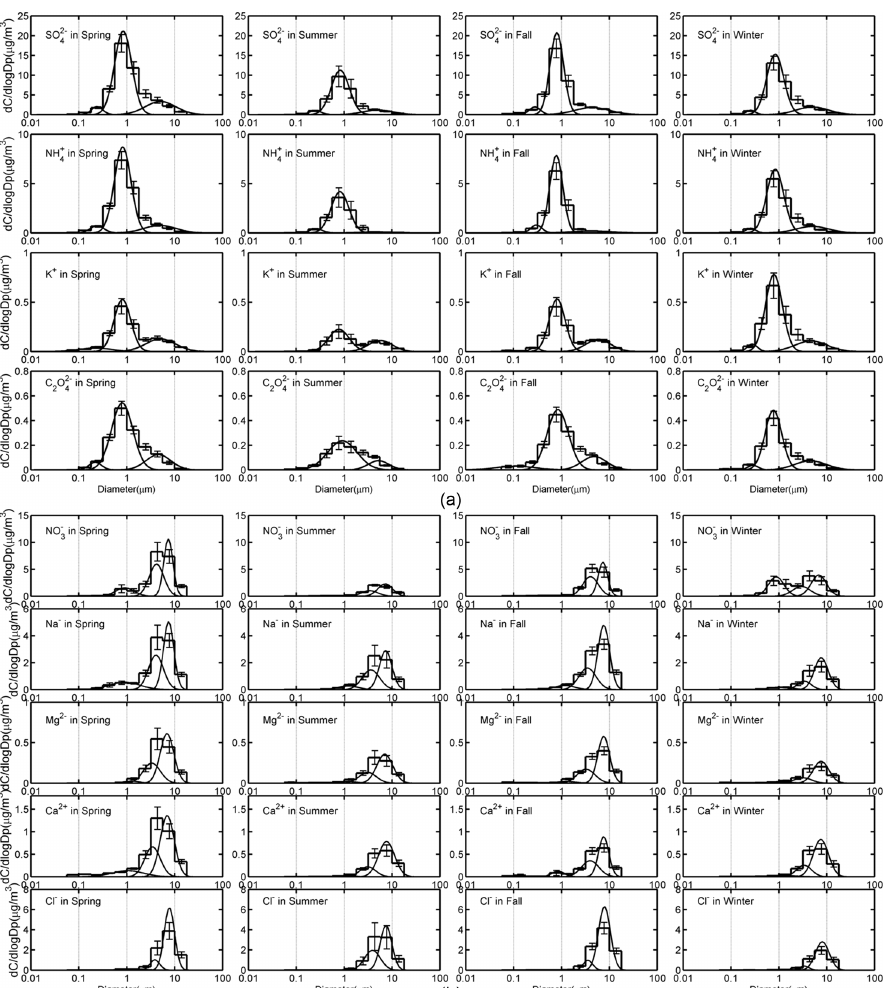
) and , NH + , K + , C 2 O 2 − 4 4 4